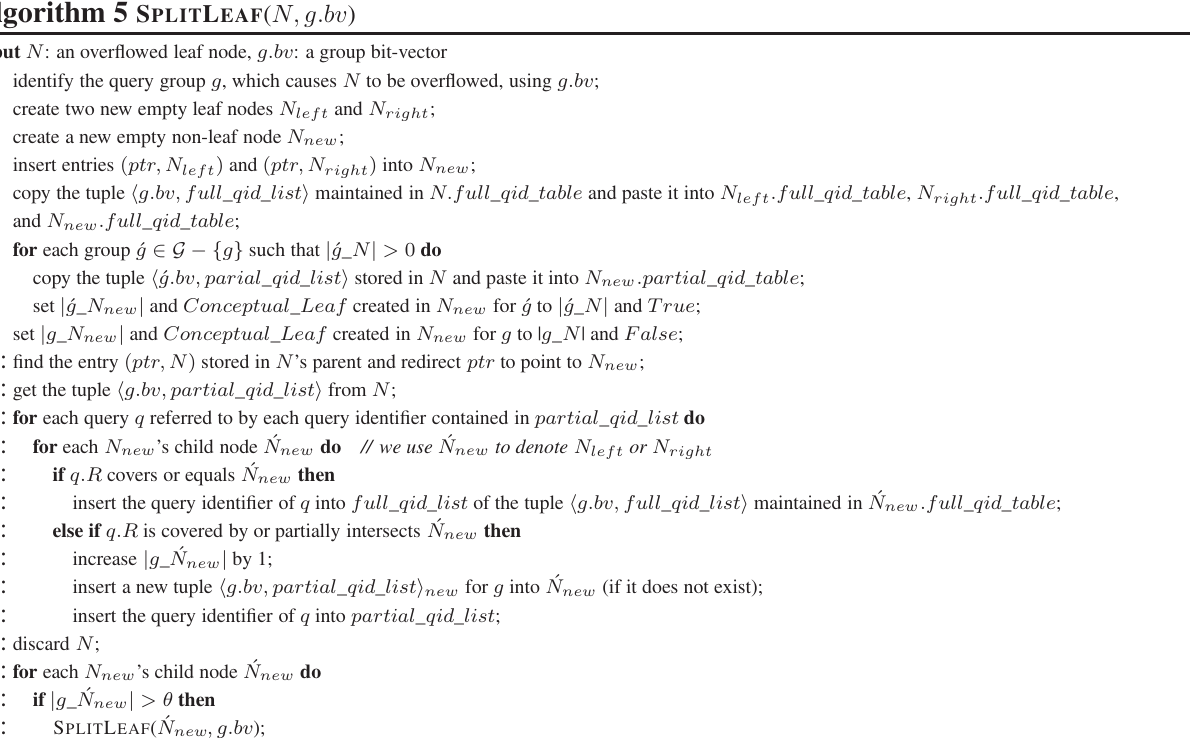
Algorithm 5 S PLIT L EAF ( N, g.bv